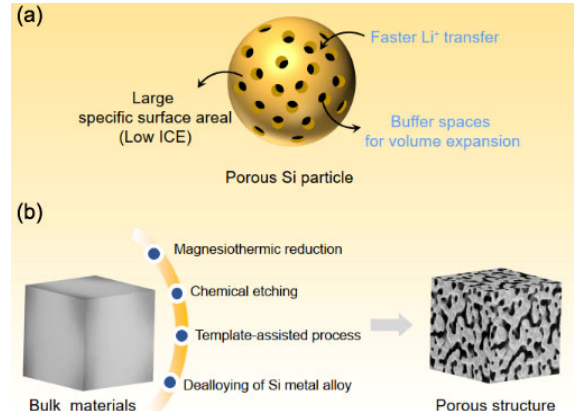
Figure 3 (a) Properties and (b) synthesis methods of